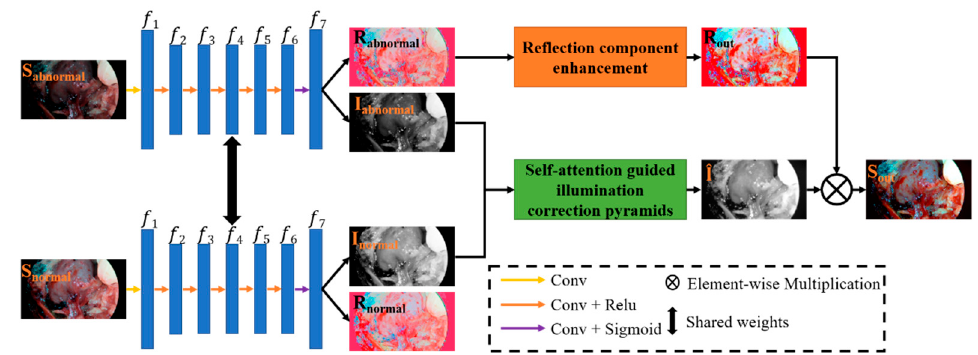
Figure 2. The framework of the proposed EIEN. The left half is the decomposition network, and the two images are decomposed with the same values of network weights. f 1 – f 7 are the extracted feature maps, where f 1 – f 6 are the features with 64 channels; f 7 are the features with 4 channels, the first three channels are the reflection components, and the last channel is the illumination component. The right half is divided into three steps illumination and reflection component enhancement and reconstruction of the image.